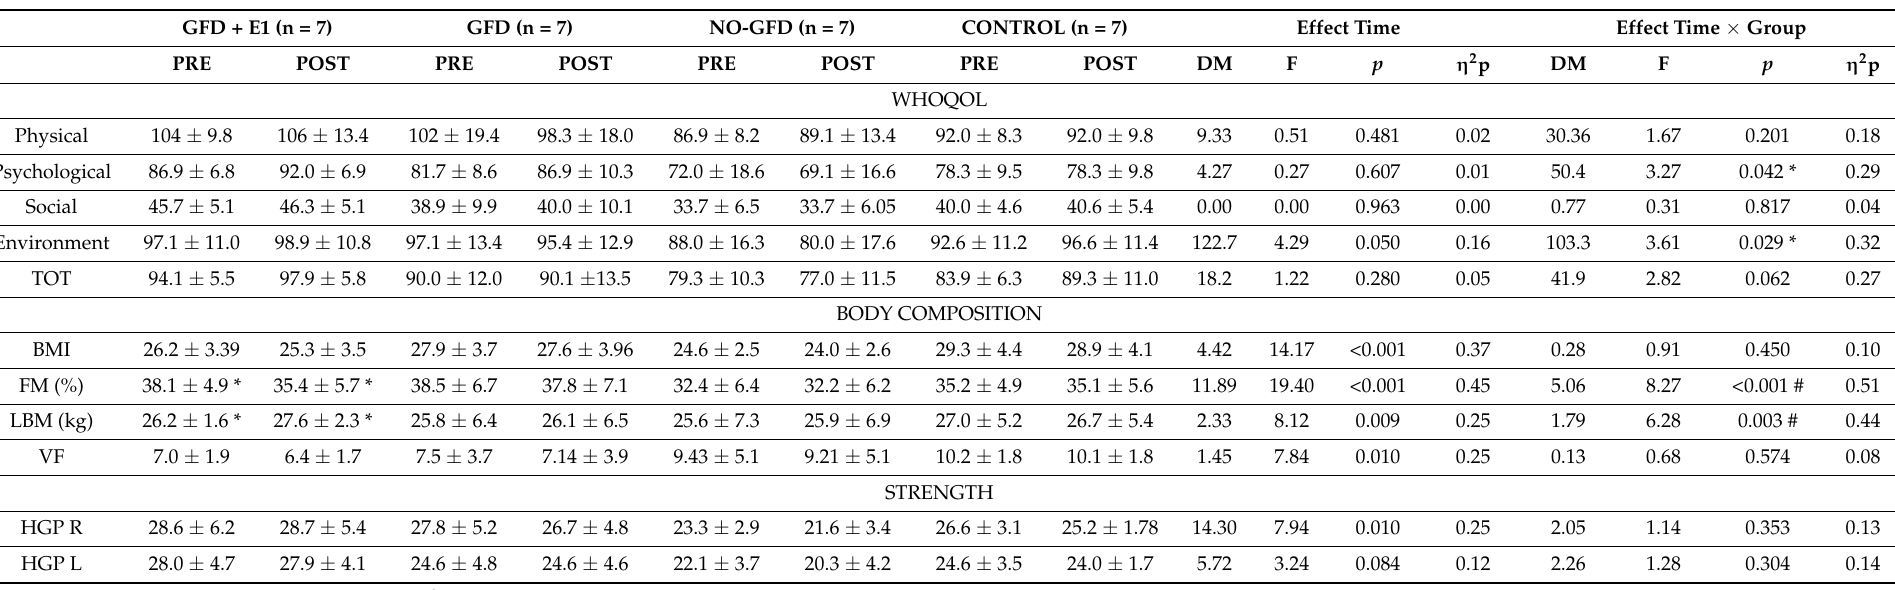
Table 3. Comparison characteristics at baseline and after intervention (ANOVA) presented as mean ± standard